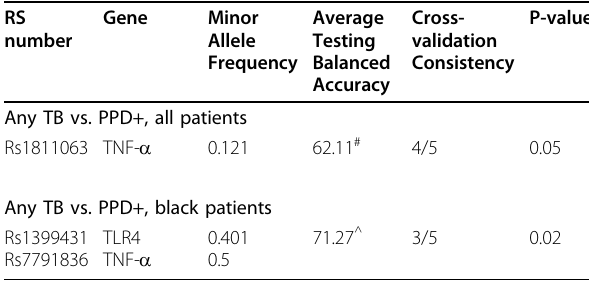
Table 5 Of the SNPs Listed in Table 4, the SNPs Associated with Tuberculosis in This Study